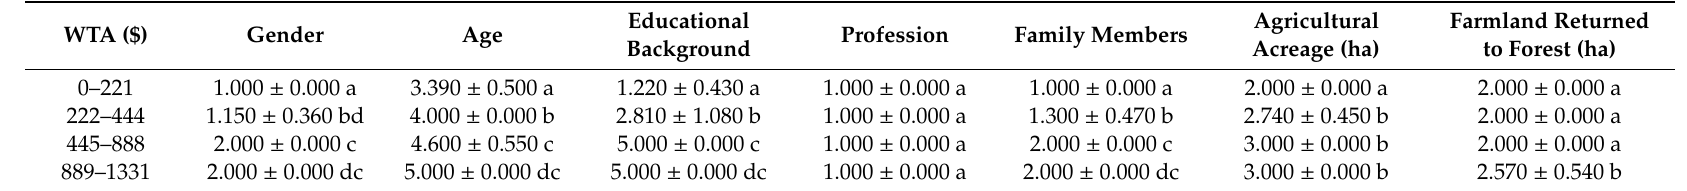
Table 4. E ff ects of social and economic variables on willingness to accept payment